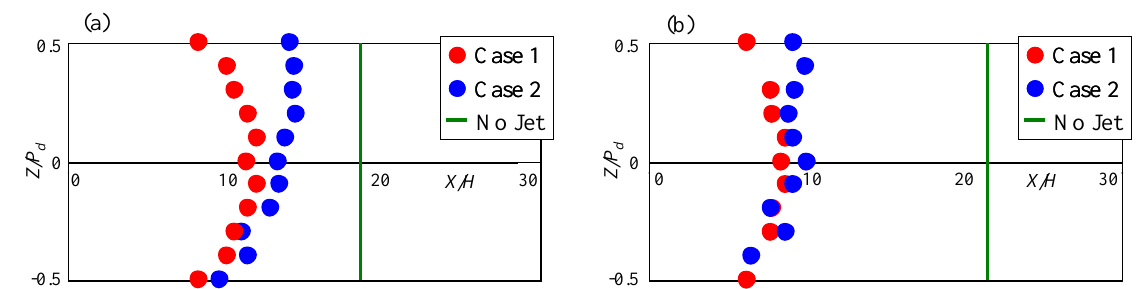
Time-averaged reattachment point in the spanwise direction at case 1 and 2 in (a) Re = 500 and F and (b) Re= 900 and F = 150 SJ